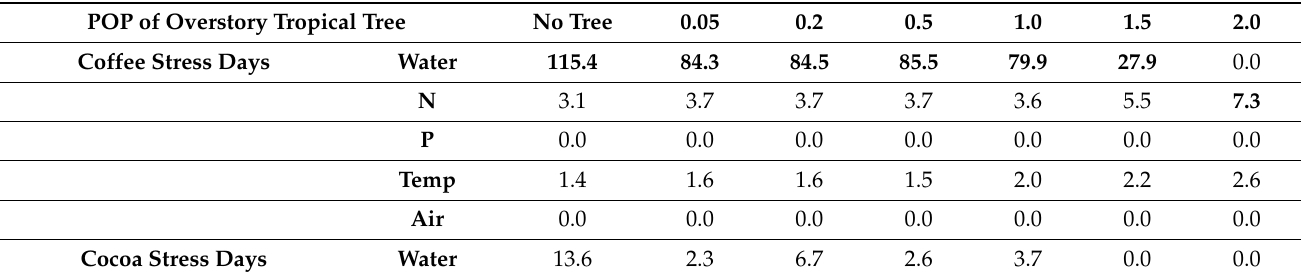
Table 12. Simulated days of stress listed by type of stress per species at each density of overstory tropical tree. Coffee and cocoa simulations with tropical tree overstory growth planted five years prior to crop. POP is the plants per 100 m 2 of the tropical trees. Water is drought stress, N is nitrogen, P is phosphorus, Temp is temperature, and Air is aeration (flooding) stress. The bold values are the stress that was highest for the plant at that